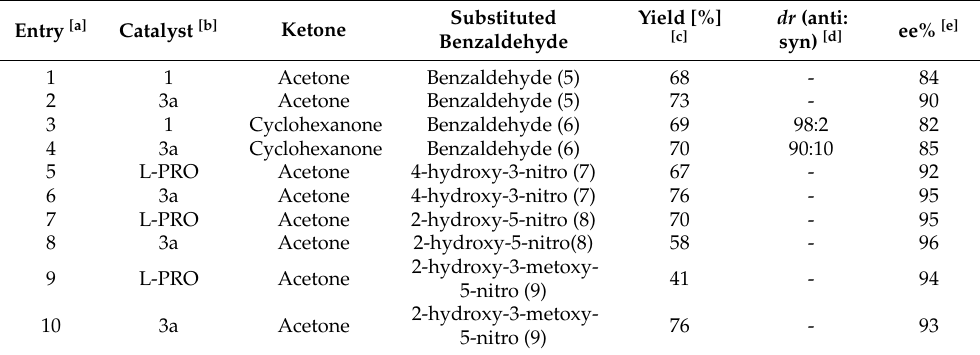
Table 2. Studies on asymmetric aldol reactions with different